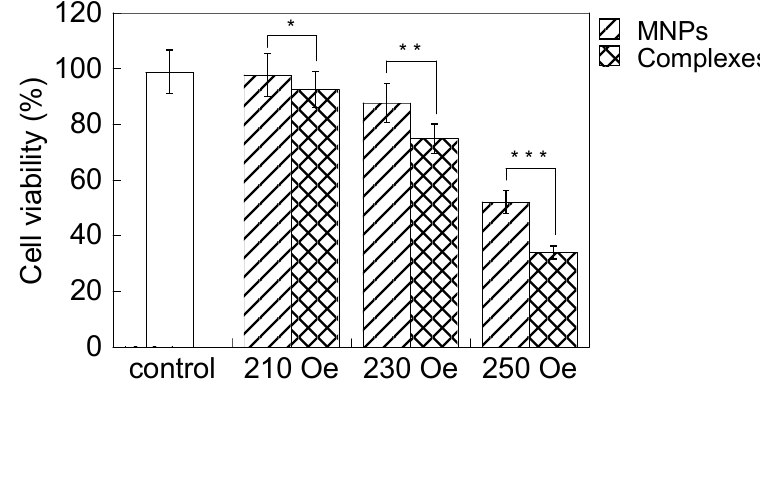
Figure 7. HeLa cell viability with added PEI-coated MNPs or MNP/antibody complexes and the application of an AC magnetic field for 1 h. The magnetic field intensities were 210, 230 and 250 Oe. The AC magnetic field frequency was 210 kHz. The control did not include MNPs or complexes while applying an AC magnetic field of 250 Oe. Cell viability decreased with increased magnetic field intensity. The complexes decreased cell viability compared with PEI-coated MNPs. The confirmation of cell viability decrease by adding the complexes in each magnetic field is marked with an asterisk ( p <